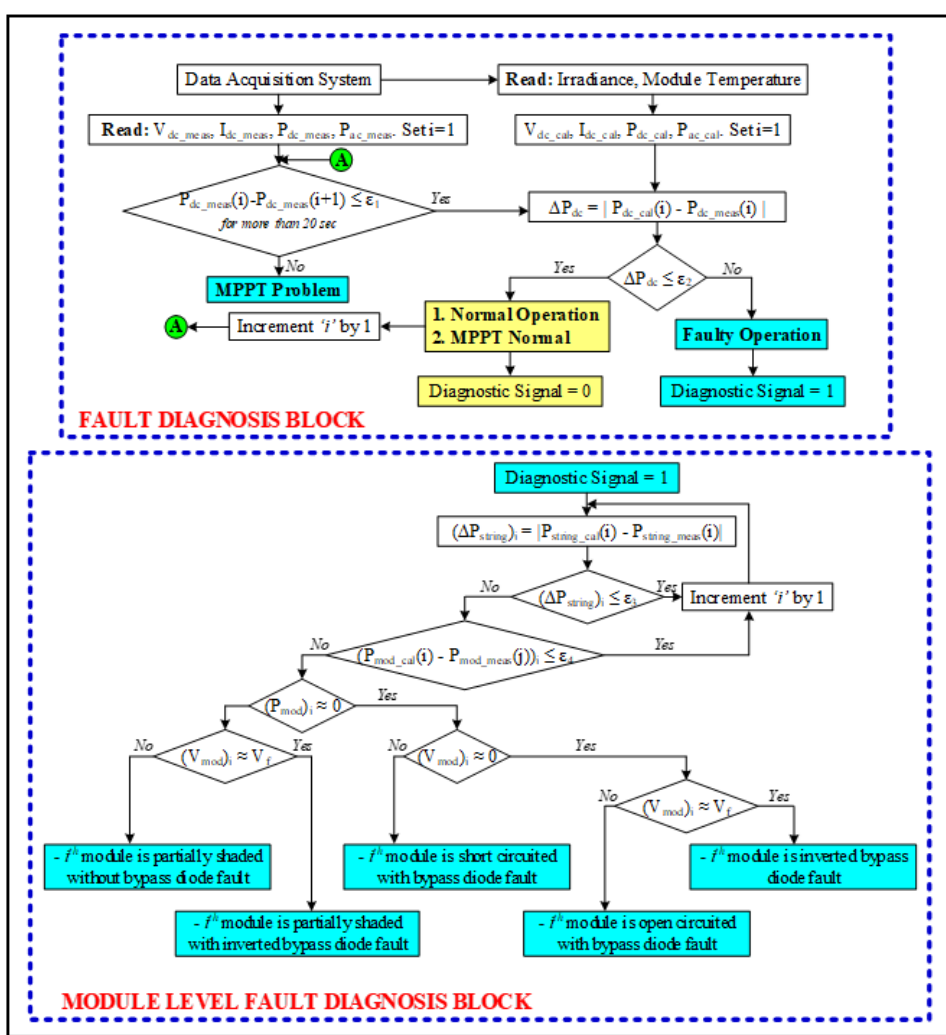
Figure 5. Flowchart for fault detection in PV arrays.